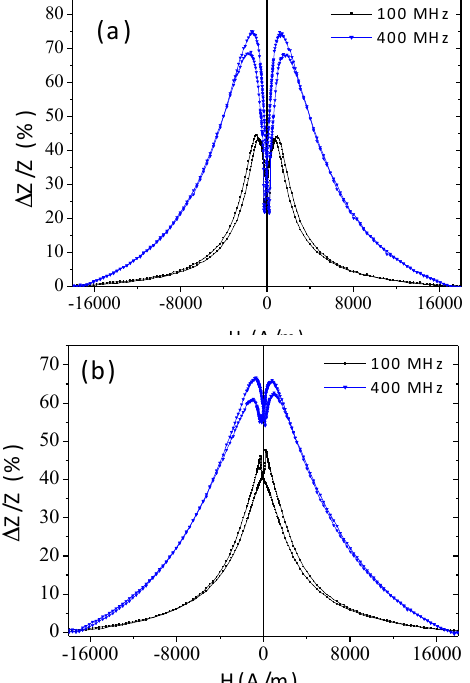
Figure 3: Δ Z/Z (H) dependences of as-prepared (a) and annealed at 200 o C for 5 min (b) measured at different